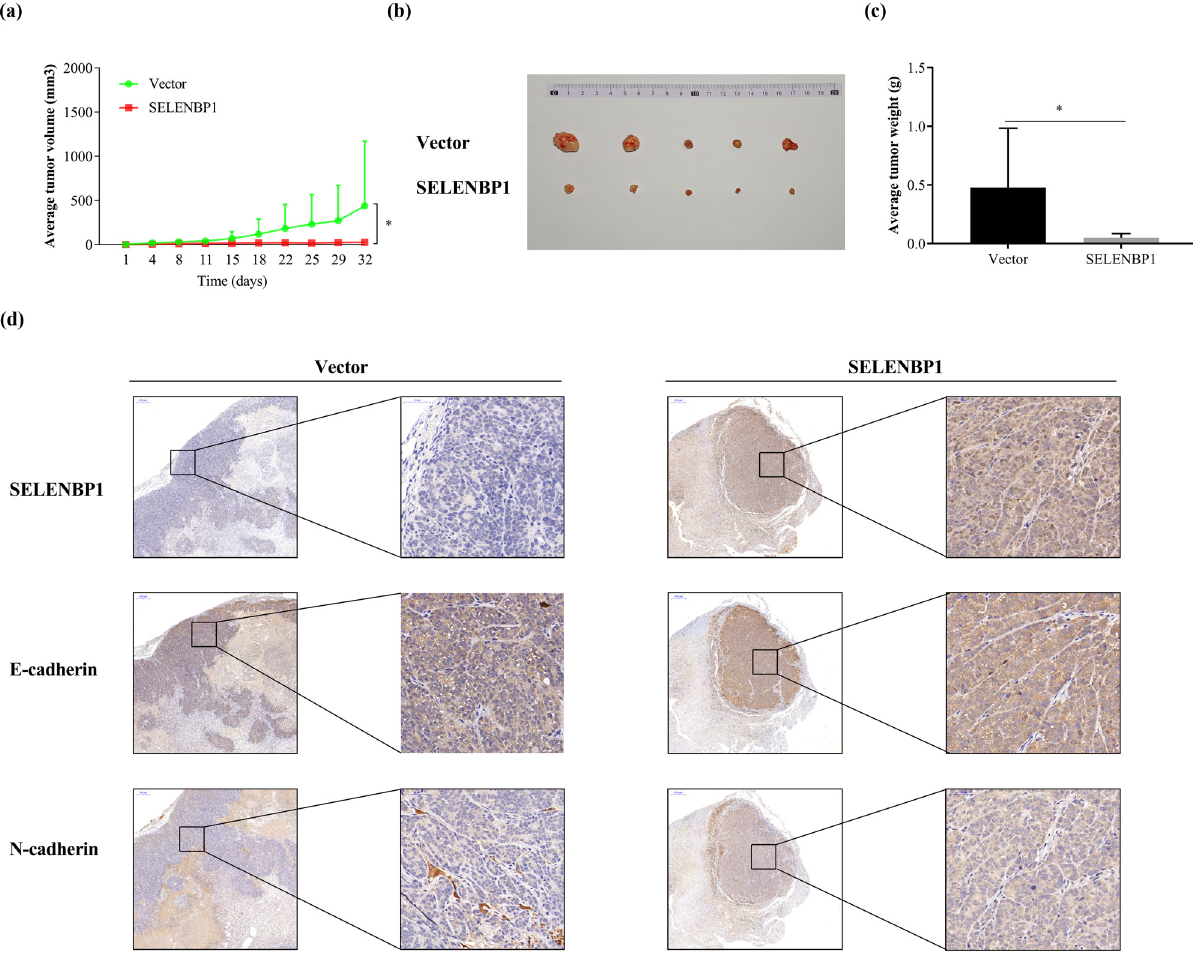
Figure 6: SELENBP1 inhibits tumorigenesis of CRC cells. HCT - 15 cells stably overexpressing SELENBP1 or vector were inoculated subcuta - neously into the right fl ank of nude mice ( n = 5 per group ) . Tumor growth was monitored twice a week ( a ) . On Day 32 after inoculation, tumors were removed, photographed ( b ) , and weighed ( c ) . Formalin - fi xed and para ffi n - embedded tumor blocks were cut into 5 μ m sections and stained with respective antibodies against SELENBP1, E - cadherin, and N - cadherin ( d ) . * p < 0.05 vs the control